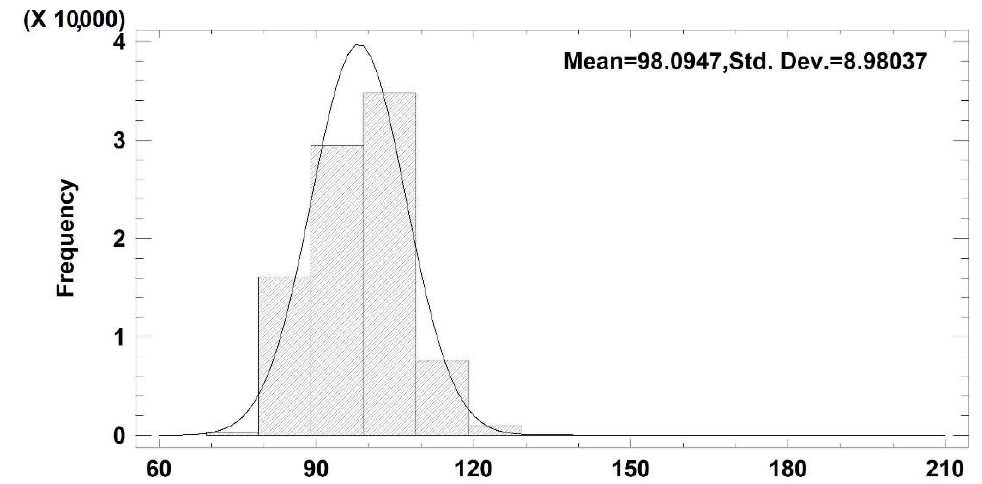
Figure 4. Histogram (Index classes) of WLDI and application in Crete islands (1999–2014).